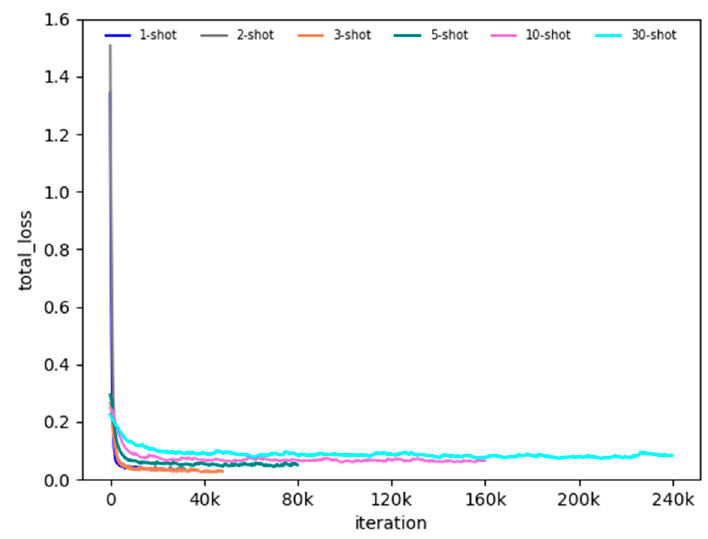
Figure 6. The total loss of 𝑛 -shot fine-tuning.